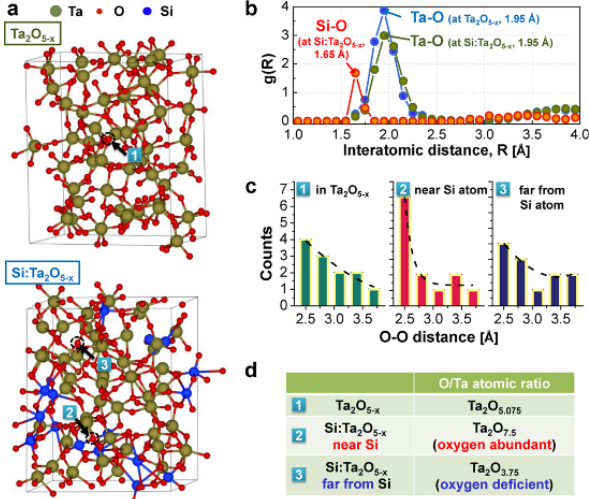
Figure 8: (a) Photographs of the amorphous Ta 2 O 5− x and Si-doped Ta 2 O 5− x structures attained in the ab initio simulation. The Ta, O, and Si atoms are colored in dark green, red, and blue,